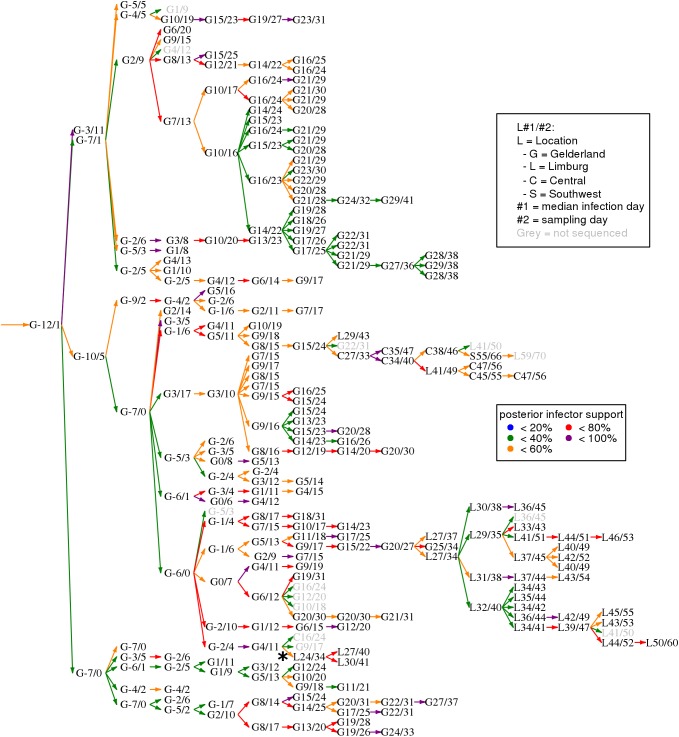
Consensus Edmonds’ transmission tree for the H7N7 dataset [12, 28, 30].Infected premises are (not uniquely) coded by location (as in [12]), median posterior infection day, and sampling day. Coloured arrows indicate most likely infectors, with colours indicating the posterior support for that infector. The asterisk (*) indicates the exceptionally long generation time at the start of a small Limburg cluster.